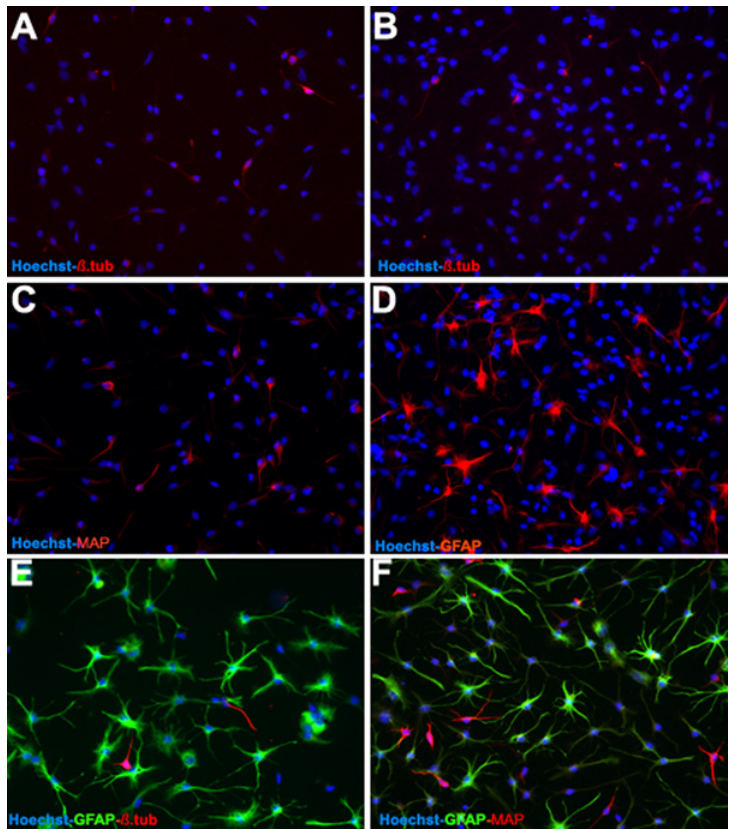
Fig 5. The differentiation potential of OBNS/PC-GFP-hNGF was assessed by examining their reactivity against different neuronal and glial cells molecular markers between passage 12 – 15. In comparison to wild type (control) OBNS/PC and OBNS/PC-GFP, differentiated OBNS/PC-GFP-hNGF exhibited positive immunoreactivity for GFAP astrocytes marker (45 – 55%) (D,E,F), MAP2 mature neuronal marker (25 – 30%) (C,D,F). β -TubulinIII, immmature neuronal marker (6%) (A,B,E). The nuclei were stained blue with